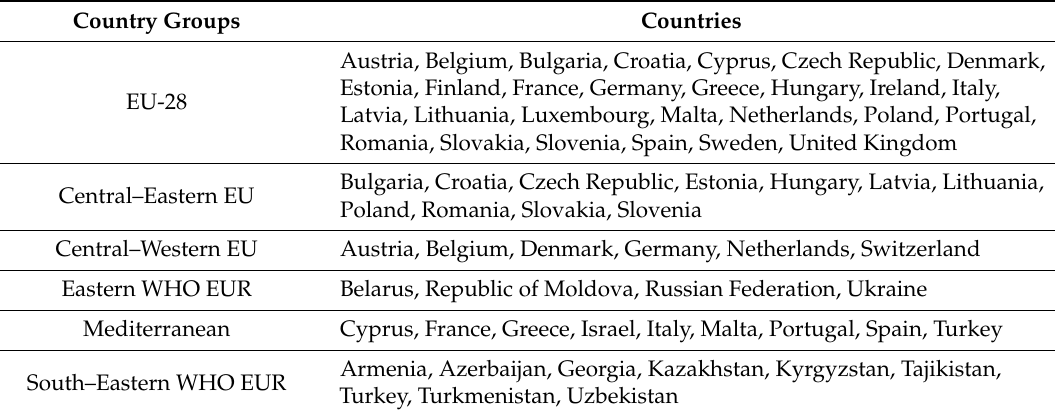
Table 1. Country groups used in the analysis